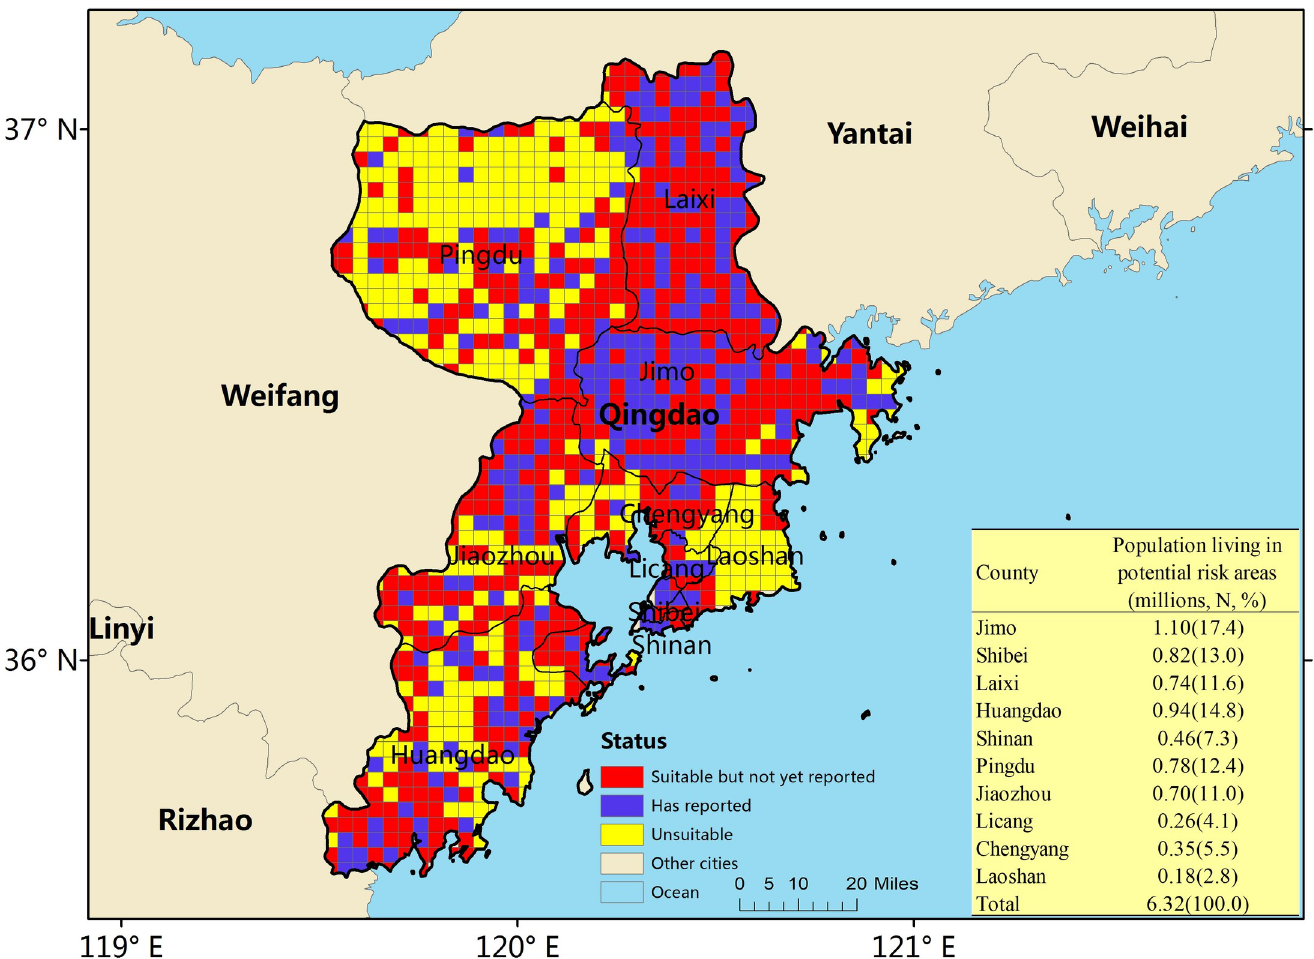
Fig 5. Status of Scrub Typhus Transmission Risk for Each Pixel in Qingdao City. The Red Areas Represent Pixels that are Environmentally Suitable (having a Suitability Value of More than 0.26) but Which have not yet Reported Scrub Typhus Cases in Humans